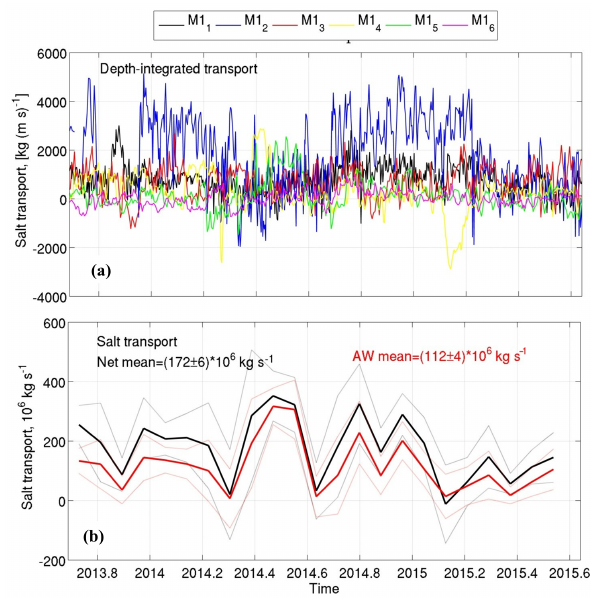
Figure 10. (a) Depth-integrated salt transports in the layer spanned by 2013–2015 CTD and velocity observations at six moorings at the Laptev Sea slope; (b) monthly net salt transport in the upper 780m layer (black) and in the Fram Strait AW layer (red) across the 125 ◦ E section. Dotted lines show 1 standard deviation